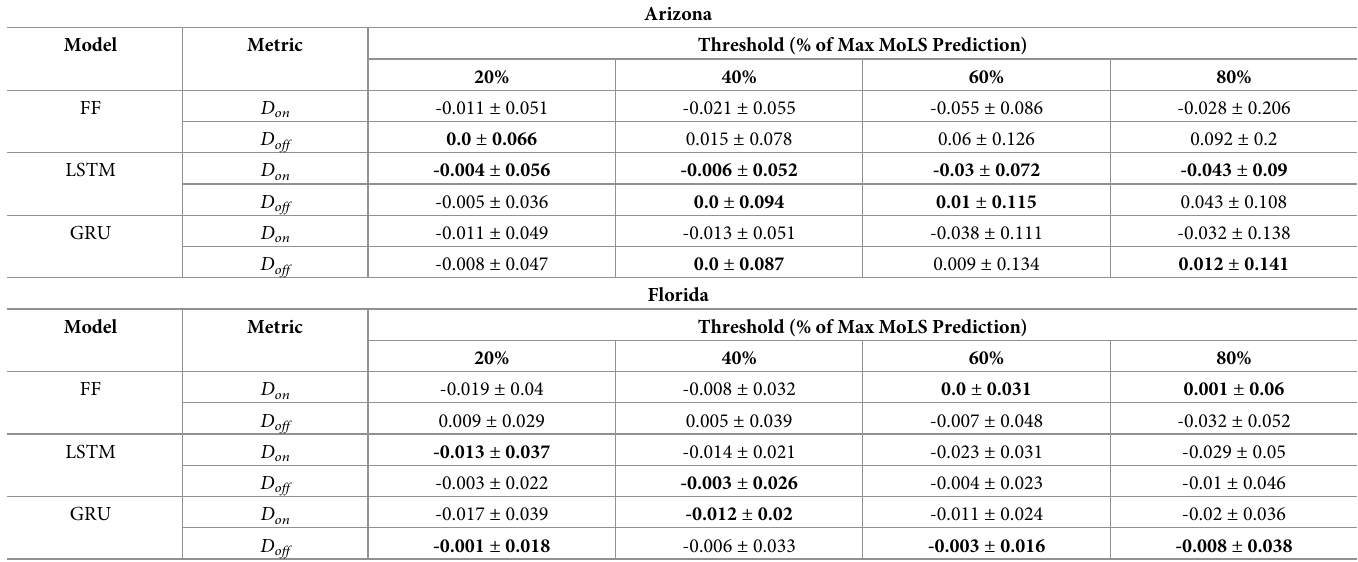
Table 4. Season feature metrics calculated for Arizona and Florida testing locations. Seasonal differences for a location and year are scaled by the average length of the season at the 20% threshold. The entries, formatted as � D � s ð D Þ , are calculated over all locations and years in each state. Bold entries correspond to the lowest values of